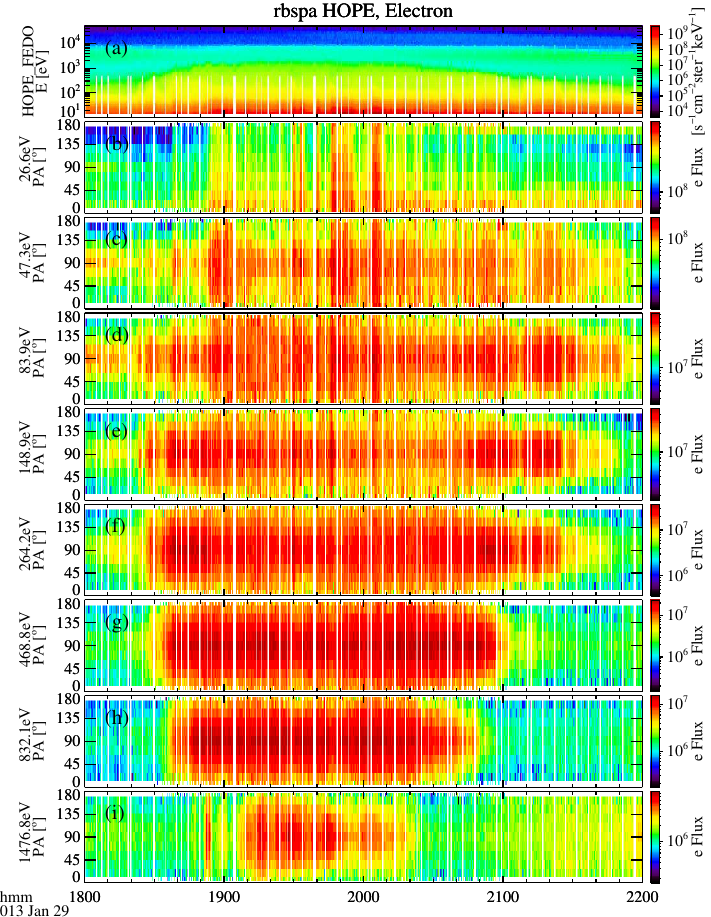
Figure 4. ( a ) Energy spectrogram of spin-averaged electron flux. ( b – i ) pitch-angle distributions of electron fluxes at energies from ∼ 26eV to 1476eV. The energy channel of each panel is marked on the